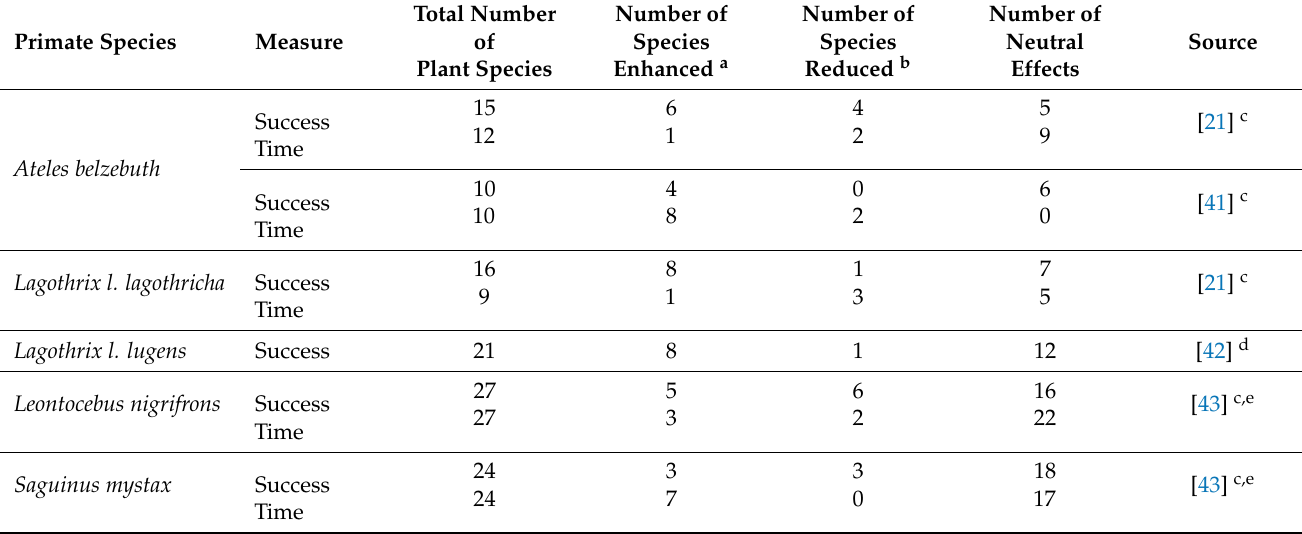
Table 5. Gut effects on seed germination in terms of success (proportion of germinated seeds) and on mean germination time (in